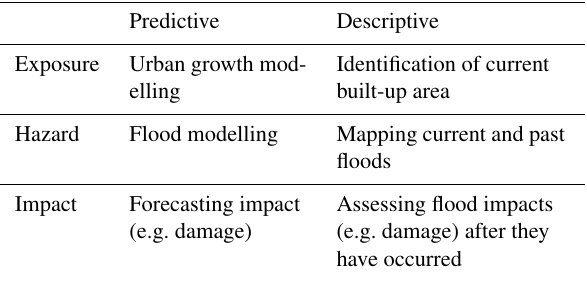
Table 1. Overview of different types of flood risk and impact as- sessments.